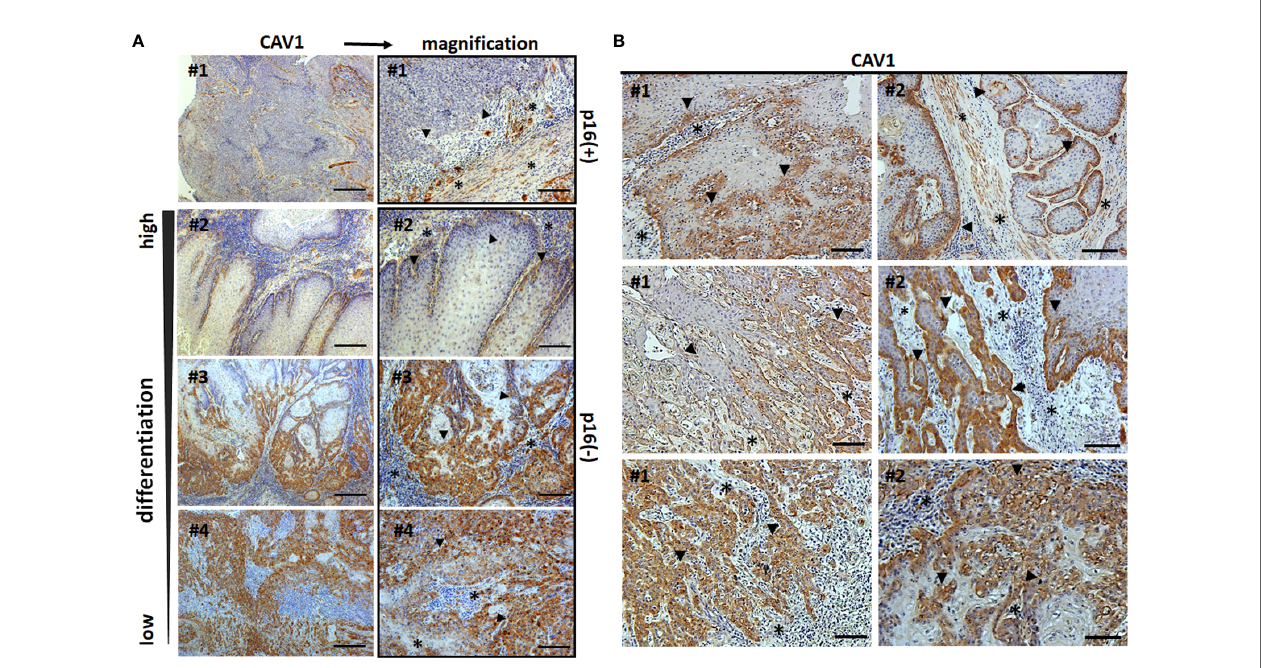
FIGURE 4 | Epithelial-stromal CAV1 distributions in correlation with malignant epithelial differentiation patterns. Paraf fi n-sections of human penile carcinomas were stained for CAV1 and analyzed according to the tumor grade. (A) Representative images of well differentiated (low-grade, G1), moderately differentiated (G2) and poorly differentiated (high grade, G3) tumors are shown. P16 status is indicated. Scale bar: 200 µm, higher magni fi cations: 50 µm. (B) Representative images of different areas with variable (decreasing tumor cell) differentiation patterns within the same (p16-negative) tumor specimen are shown. Sections were counterstained using hematoxylin. Asterisks (*) mark stromal compartments and bold arrows point to epithelial structures. # indicates different